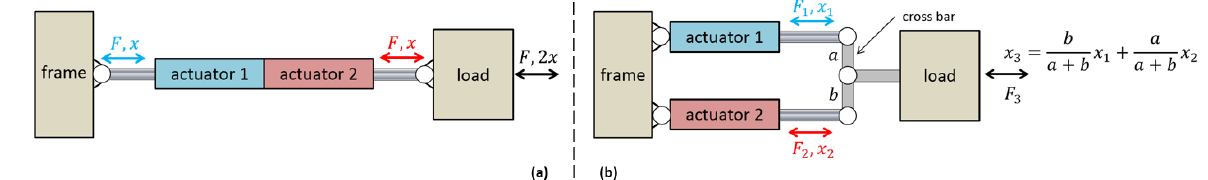
Figure 21. Redundant topologies of actuator in position summing (passive/failed actuator shall be locked). ( a ) One tandem actuator, ( b ) two simplex actuators linked by a cross bar ( a = b considered, F 1 = F 2 = F 3 /2).